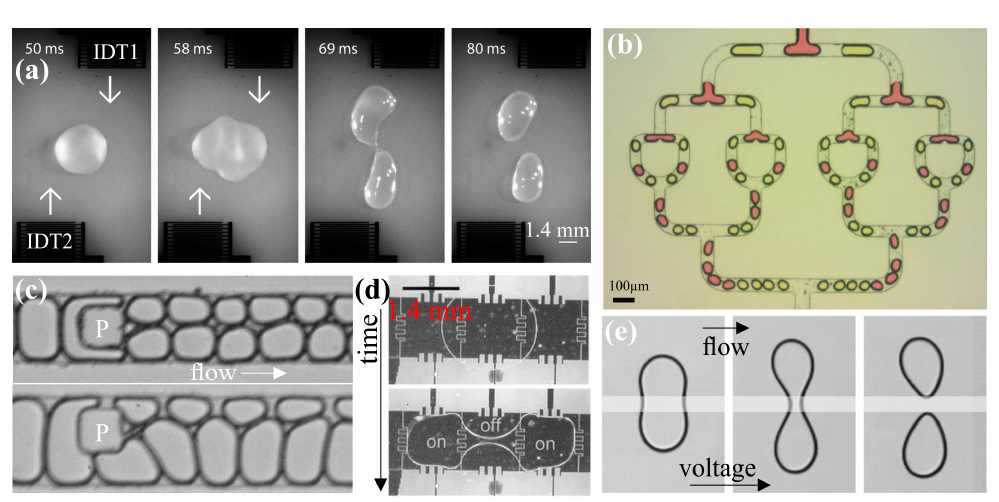
Figure 6. Overview of splitting methods. ( a ) Two off-axis IDTs create two SAWs that apply a torque on a 3 µL droplet, splitting it in two. Adapted from [71] with permission of The Royal Society of Chemistry. ( b ) Passively, using a multiple consecutive T-junctions, a slug can be split into 16 equal sized droplets. Reproduced from [3] with permission of The Royal Society of Chemistry. ( c ) Top: A pillar in the center of a channel splits droplets into equal volumes. Bottom: An off-center pillar splits droplets in unequal volumes. Reprinted with permission from [4]: Link et al. , Phys. Rev. Lett. 2004, 92 , 054503. Copyright 2004 by the American Physical Society. ( d ) By activating a row of three EWOD electrodes a drop will elongate. After deactivating the central electrode, a bridge is formed, splitting the droplet in two equal volumes. Copyright 2003 IEEE. Reprinted, with permission, from [13]. ( e ) Similar to EWOD, a droplet in oil flow will split in two equal volumes if the voltage across the electrostatic potential rails is high enough. The drag force assists in the breakup of the neck. Reproduced from [26] with permission of The Royal Society of Chemistry.